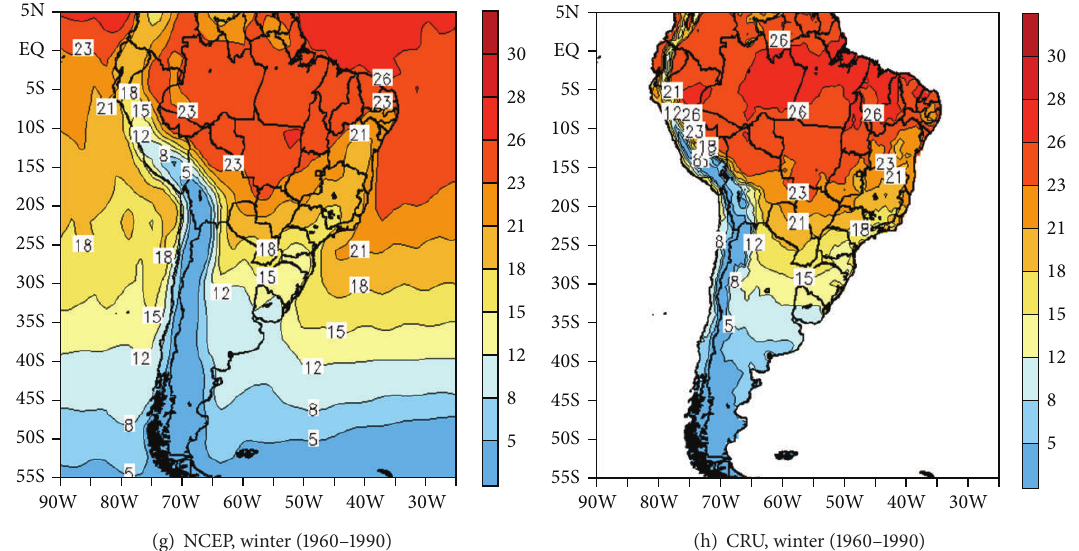
(g) NCEP, winter (1960–1990) Figure 2: Mean air temperature ( ∘ C) in ((a)–(d)) summer and ((e)–(h)) winter from 1960 to 1990 in RegHad, RegECHAM, NCEP, and CRU.